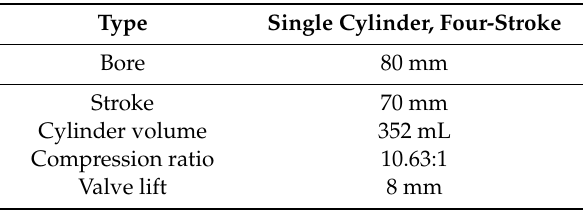
Figure 5. 3D model of the engine in the exhaust stroke. ( a ): The 3D engine model; ( b ): The refined regions of the moving parts. Table 4. Technical parameters of the